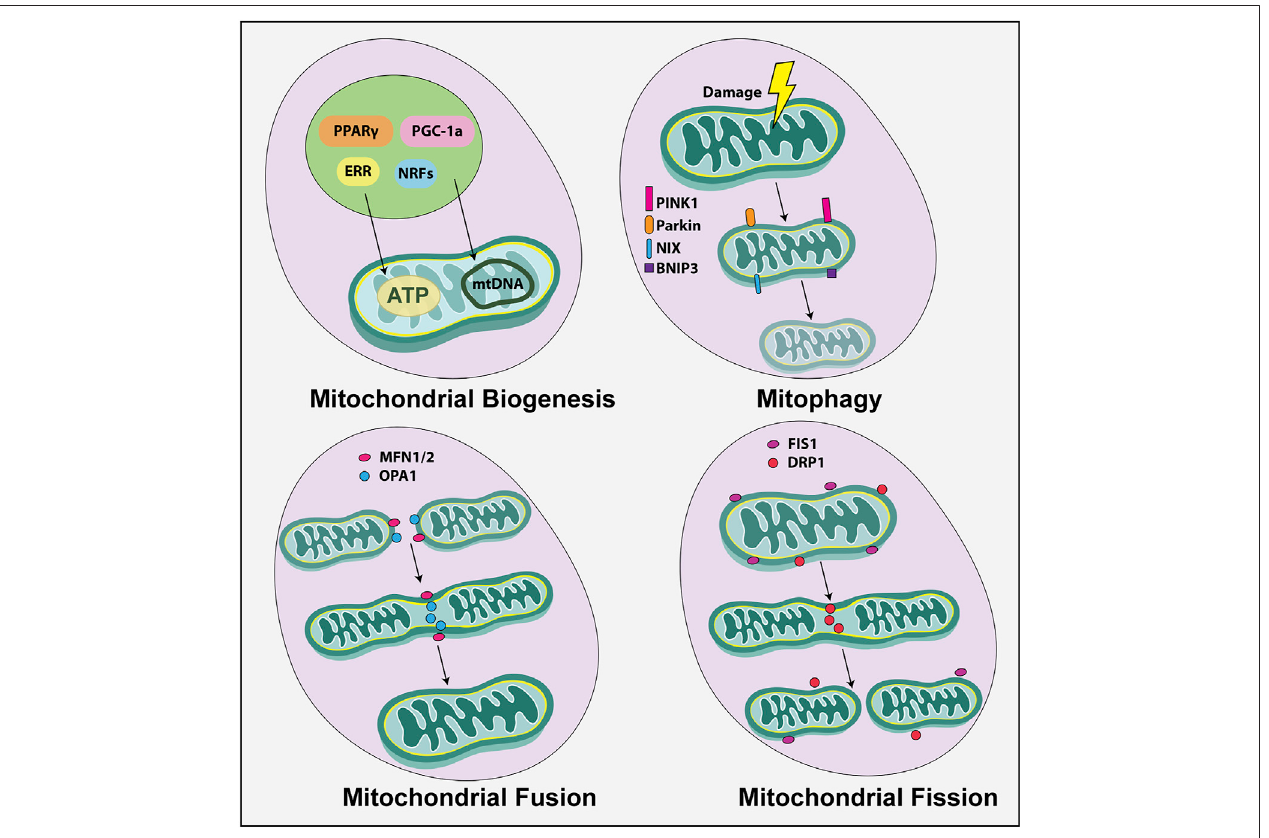
FIGURE 4 | Mitochondrial dynamics. Mitochondria are dynamic structures. Mitochondrial biogenesis, or the formation of new mitochondria is triggered by transcriptionfactors(TF),including(PPAR γ )coactivator1 α (PGC-1a),estrogen-relatedreceptor(ERR)andnuclearrespiratoryfactors(NRFs).Mitochondrialbreakdown, also known as mitophagy, is controlled by PTEN-induced kinase 1 (PINK), a kinase in the outer mitochondrial membrane, and Parkin, which encodes an E3-ubiquitin ligase. Mitochondria also undergo dynamic shape changes including fusion and fi ssion. Mitochondrial fusion, which is mediated by MFN1, MFN2, and OPA1, elongates mitochondria, while mitochondrial fi ssion or fragmentation is mediated by DRP1 and FIS1.